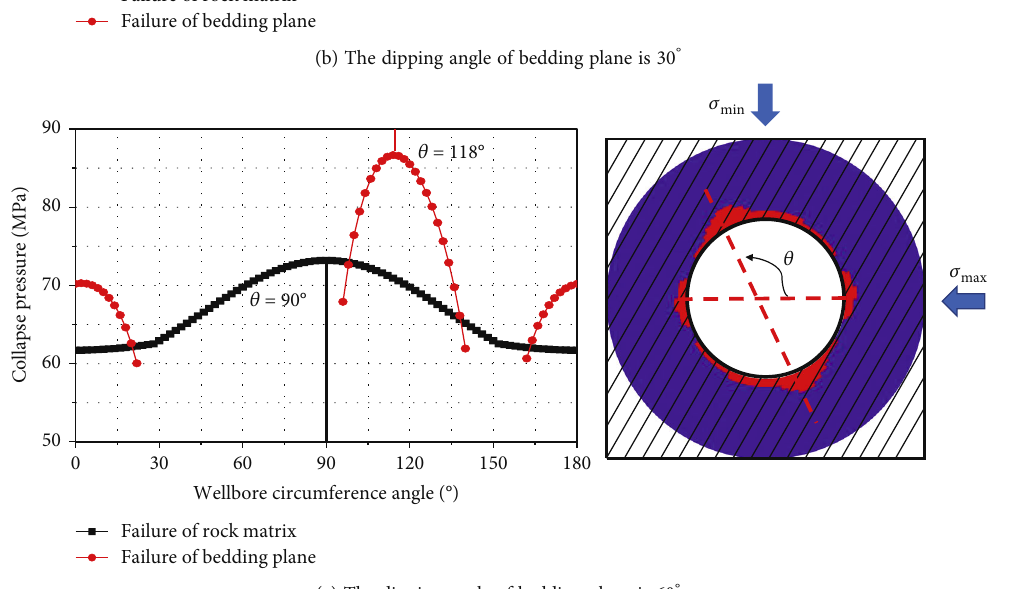
Figure 9: Polar plots of shale gas well collapse pressure under di ff erent moisture